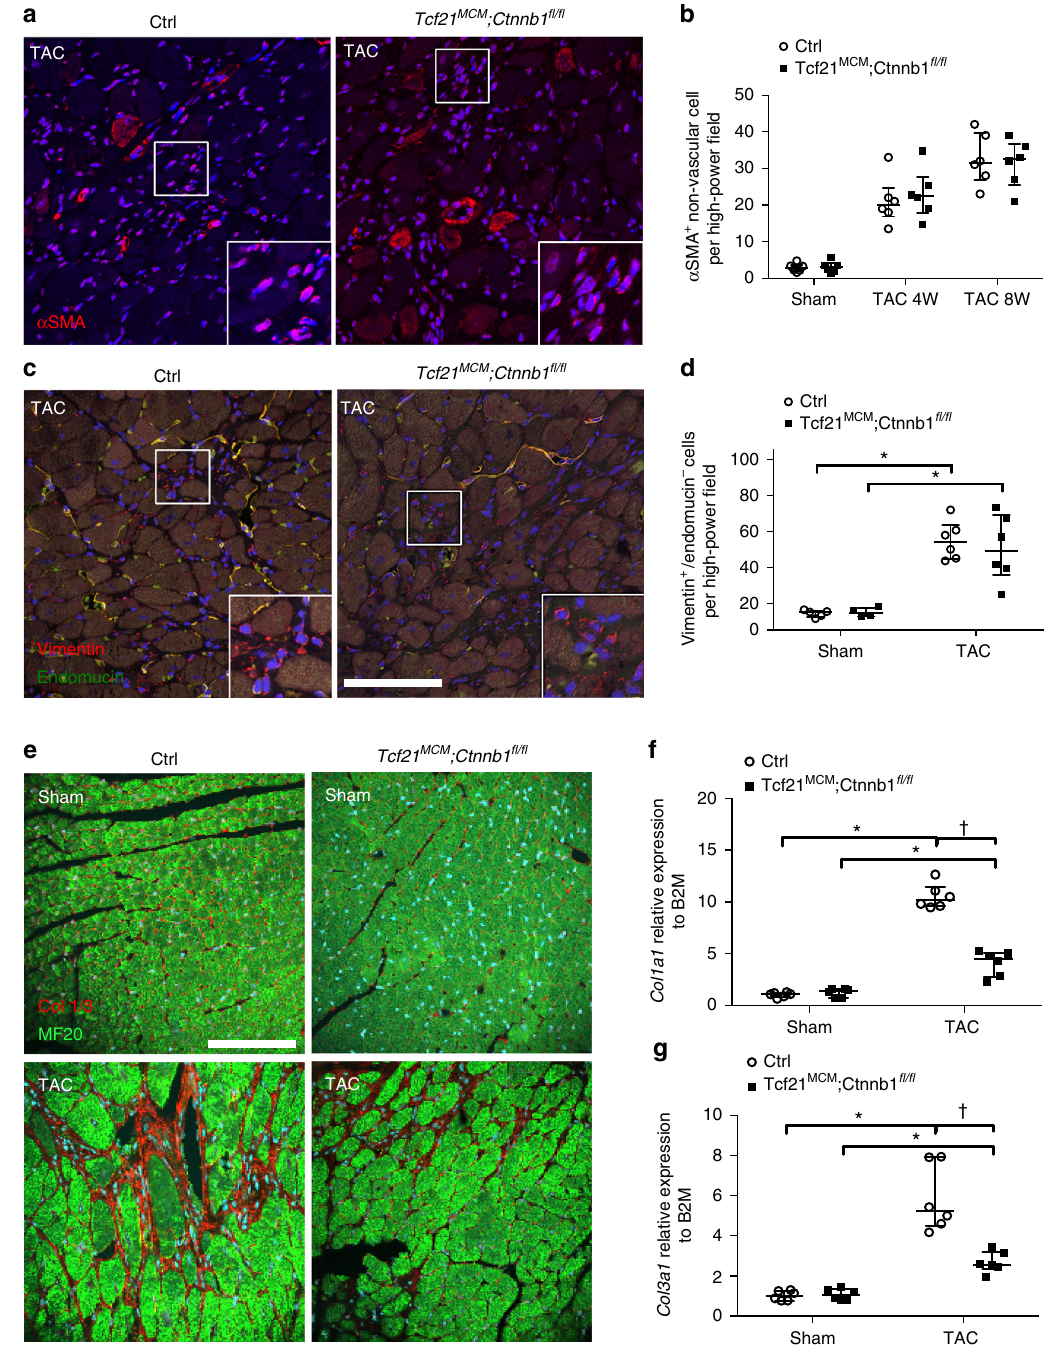
Fig. 5 Loss of β -catenin in Tcf21 lineage cells does not affect CF activation or total CF numbers but does lead to decreased Col1a1 and Col3a1 expression 8 weeks post TAC. a Representative images of α SMA staining ( red , in insets ) in Tcf21 MCM ;Ctnnb1 fl / fl and Cre-negative control hearts 8 weeks after TAC are shown. b Non-vascular α SMA + cells ( α SMA + cells surrounding vessel lumens were excluded from the analysis) were identi fi ed as activated CFs and quanti fi ed. c Representative images of vimentin ( red ) and endomucin ( green ) co-staining in Tcf21 MCM ;Ctnnb1 fl / fl and Cre-negative control hearts 8 weeks after TAC are shown. Vimentin + /endomucin − cells were identi fi ed as CFs ( red cells in insets) and d quanti fi ed. e Representative images for collagen 1/3 (Col1/3) immuno fl uorescence ( red ) co-stained with MF20 ( green ) in Tcf21 MCM ;Ctnnb1 fl / fl and Cre-negative control hearts are shown. Scale bar = 100 μ m. Quantitative PCR analysis of Col1a1 ( f ) and Col3a1 ( g ) was performed using mRNA isolated from LV free wall at 8 weeks post operation. Data points are shown with median and interquartile ranges indicated. Statistical signi fi cance was determined by Kruskal – Wallis tests followed Mann – Whitney U tests for pairwise comparisons using Bonferonni adjustments to control for multiple testing. * P < 0.05 vs. sham, † P < 0.05 vs. Control TAC. N = 4 – 8 mice per